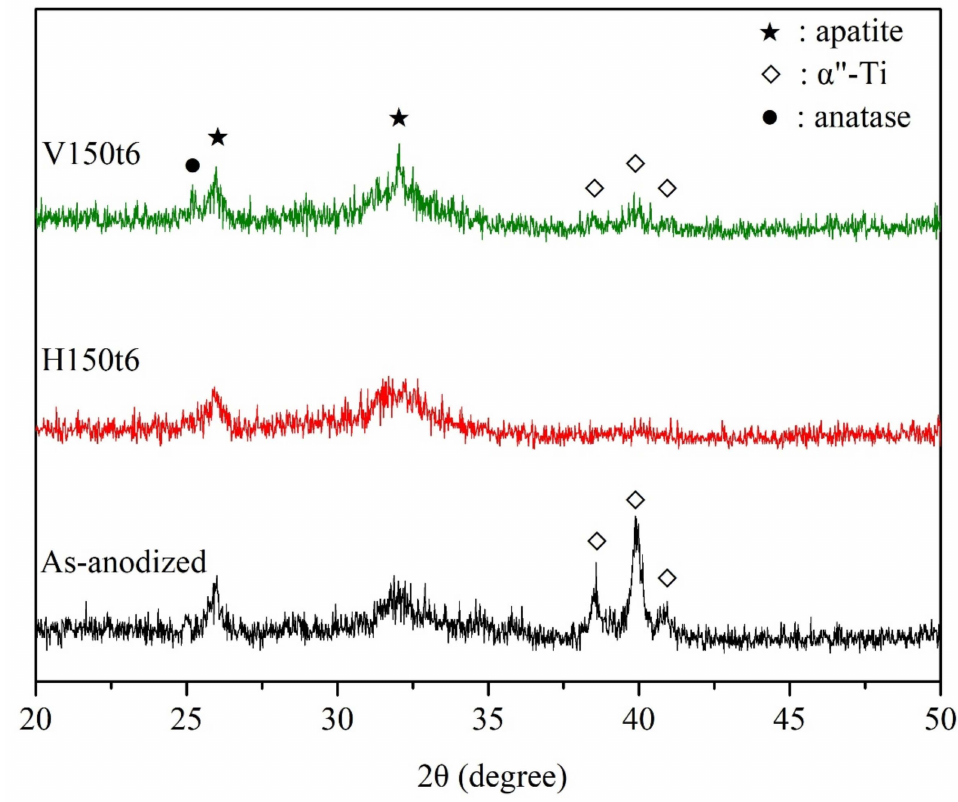
Figure 7. XRD patterns of anodized Ti–5Nb–5Mo under hydrothermal or vapor thermal treatments at 150 ◦ C for 6 h after soaking in SBF for 7